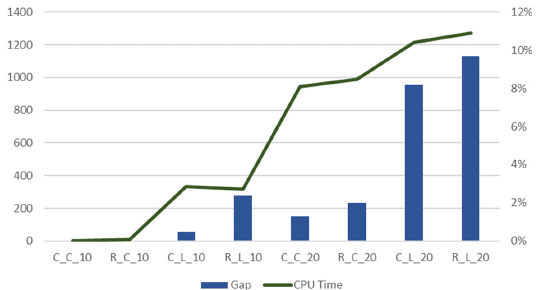
Figure 3. Optimality gap (%) and computational time (secs).